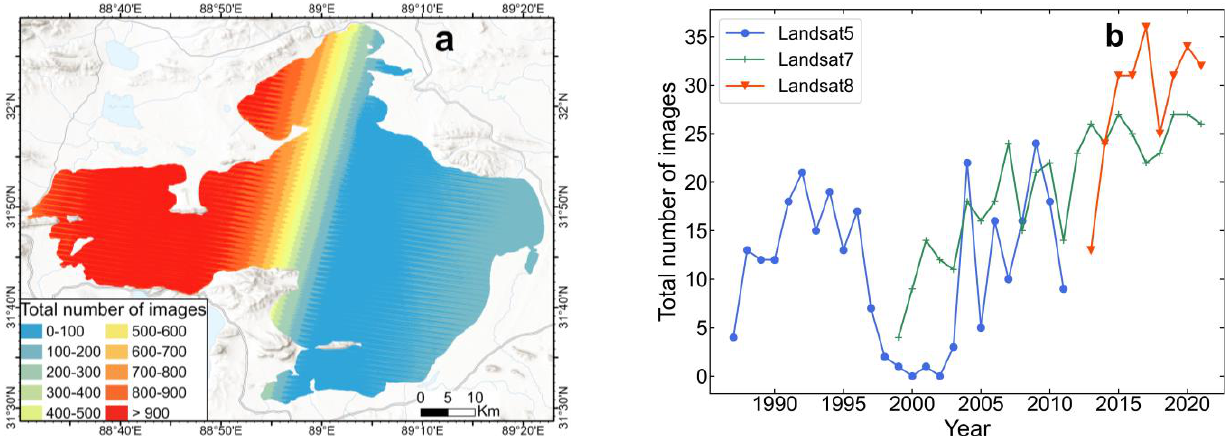
Figure 7. Spatial ( a ) and temporal ( b ) distribution of the Landsat images used in this study.